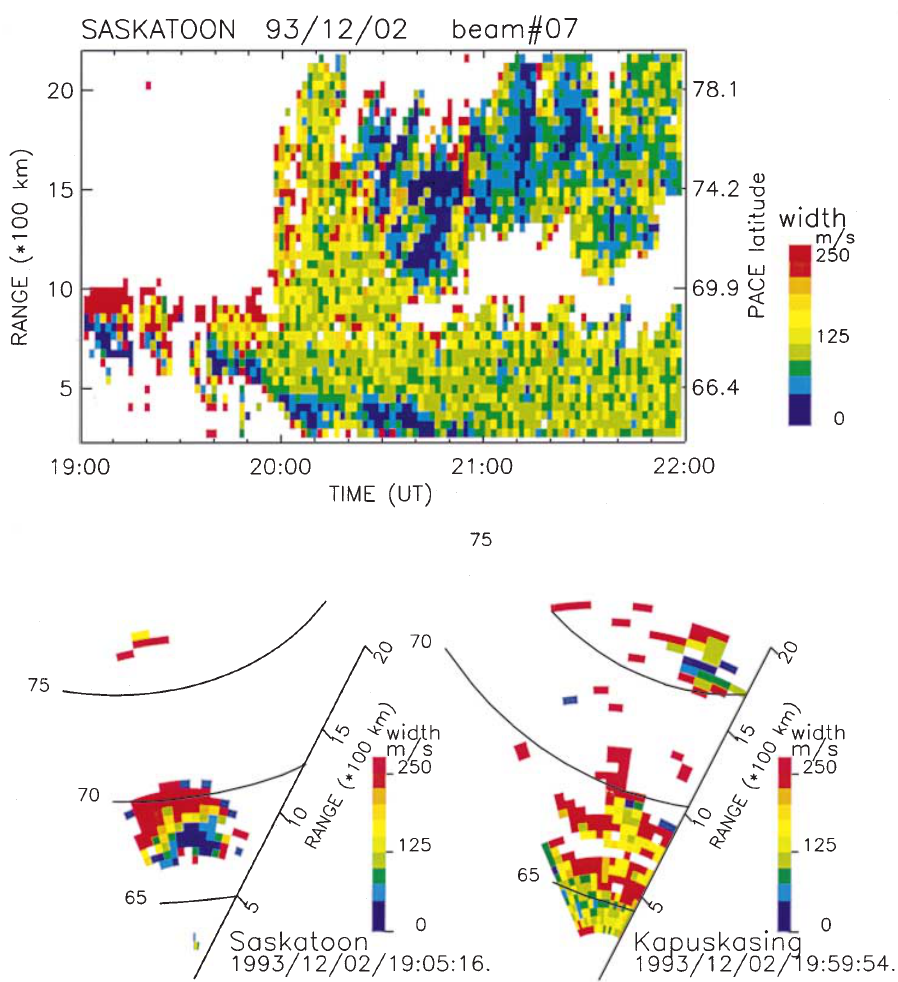
Fig. 4. Range versus time plot ( top ) and radar maps ( bottom ) of spectral widths. Radar cusp can be identified by large widths (particu- larly between 1900 and 2000 UT) while the region of small widths (<100 m/s) just equatorward of it can be associated with low latitude boundary layer (LLBL). The spec- tral widths in the patches drifting antisunward well inside the polar cap are also